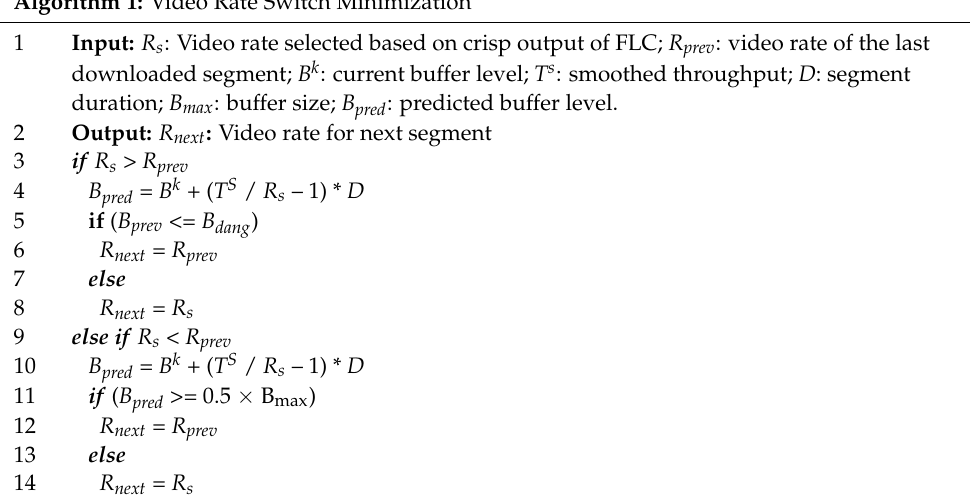
Algorithm 1: Video Rate Switch